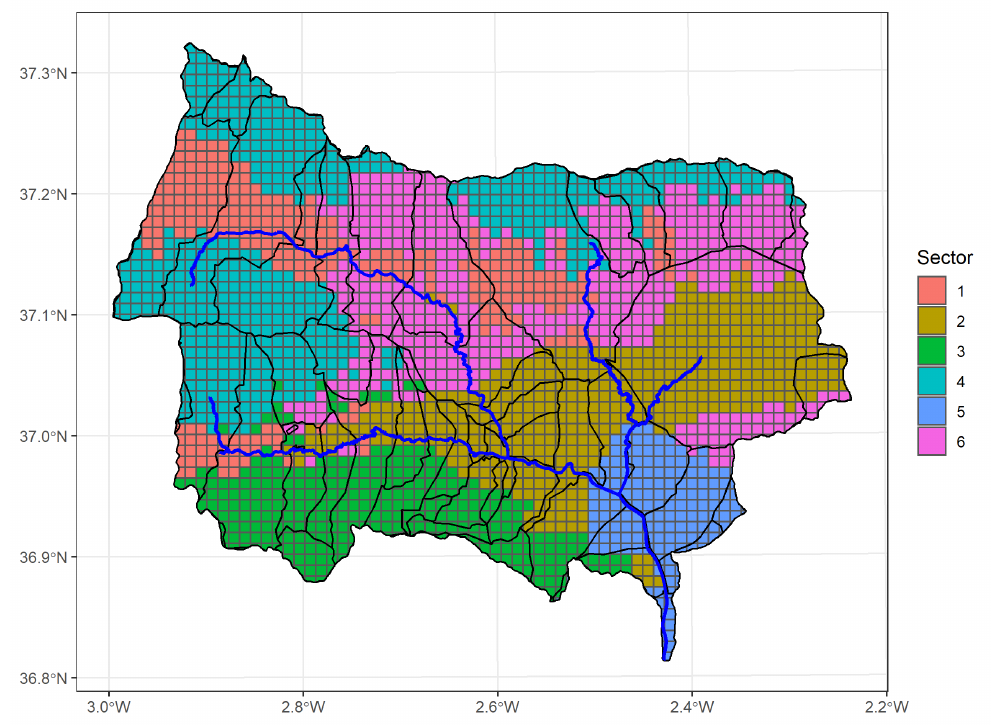
Figure 3. Observations classified into the sector that returns the highest probability, along with the municipality limits and the main river courses of the study